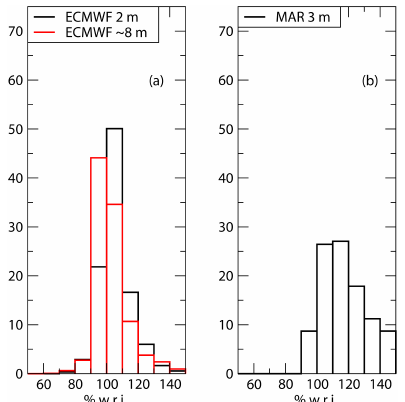
Figure 14. ECMWF-analyzed (a) and MAR-modeled (b) distribu- tions of RH i in 2015 for cases of RH i between 50 and 150%. The fact that a different time sampling in the models (this figure) and the observations (Fig. 6) does not affect the comparison was